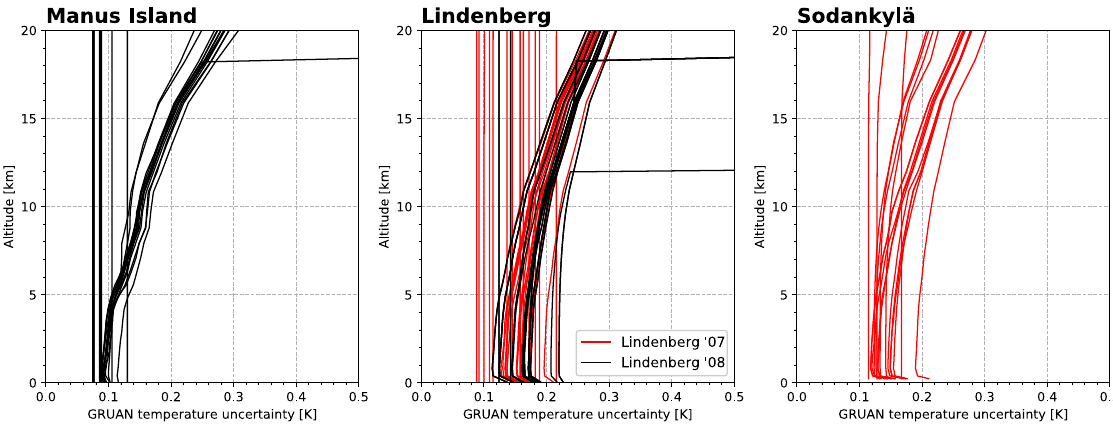
Figure A3. Profiles of the correlated temperature errors of the GRUAN radiosondes. Above the radiosonde’s top height, we use a zonally and monthly mean temperature climatology and assume an uncertainty of